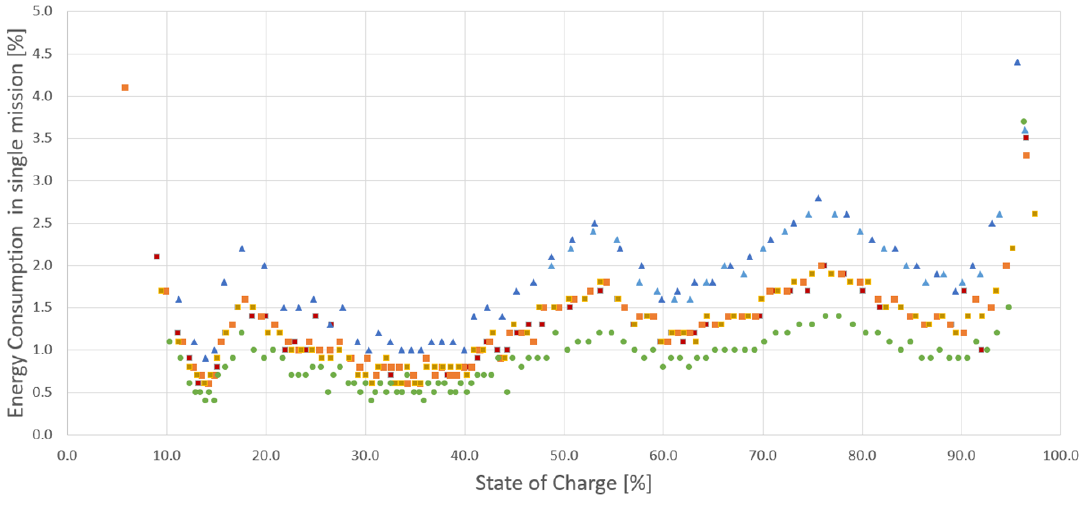
Figure 4. Battery discharge data for missions of different lengths.